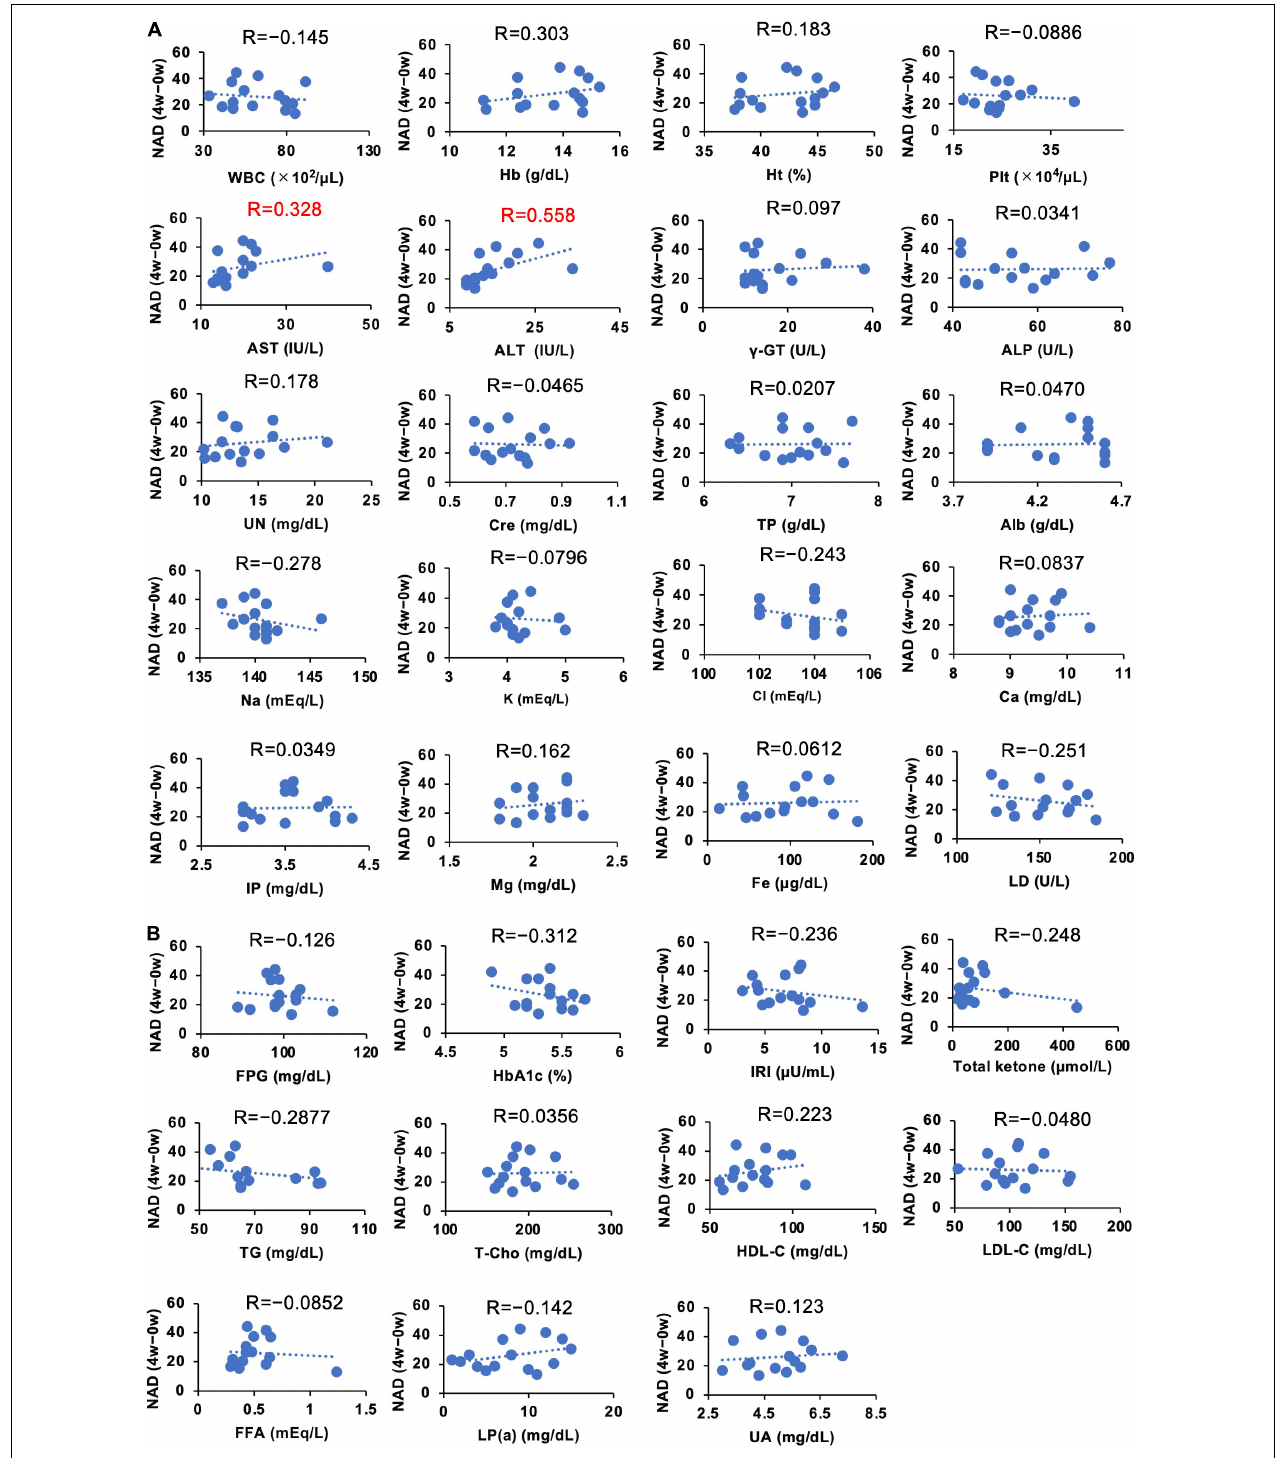
FIGURE 9 | Correlation between individual basal blood parameters and amounts of increased NAD + levels. The Y axis of each panel was fixed as the difference of blood NAD levels in 4 weeks. NAD levels at 0 weeks were subtracted from NAD levels at 4 weeks to calculate the change. Hematological and biochemical blood parameters (A) and blood parameters related to energy metabolism (B) at 0 weeks were compared with the difference of NAD at 4 weeks. Correlation coefficients were calculated by using Pearson’s correlation coefficient formula and indicated as R on the top of each panel.